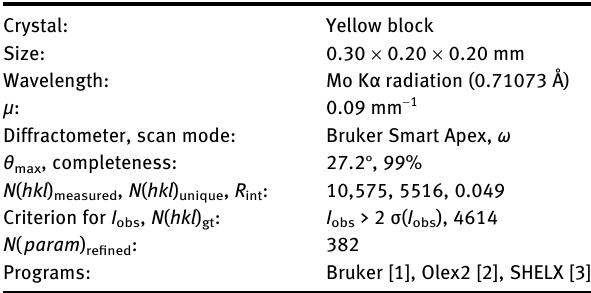
Table  : Data collection and